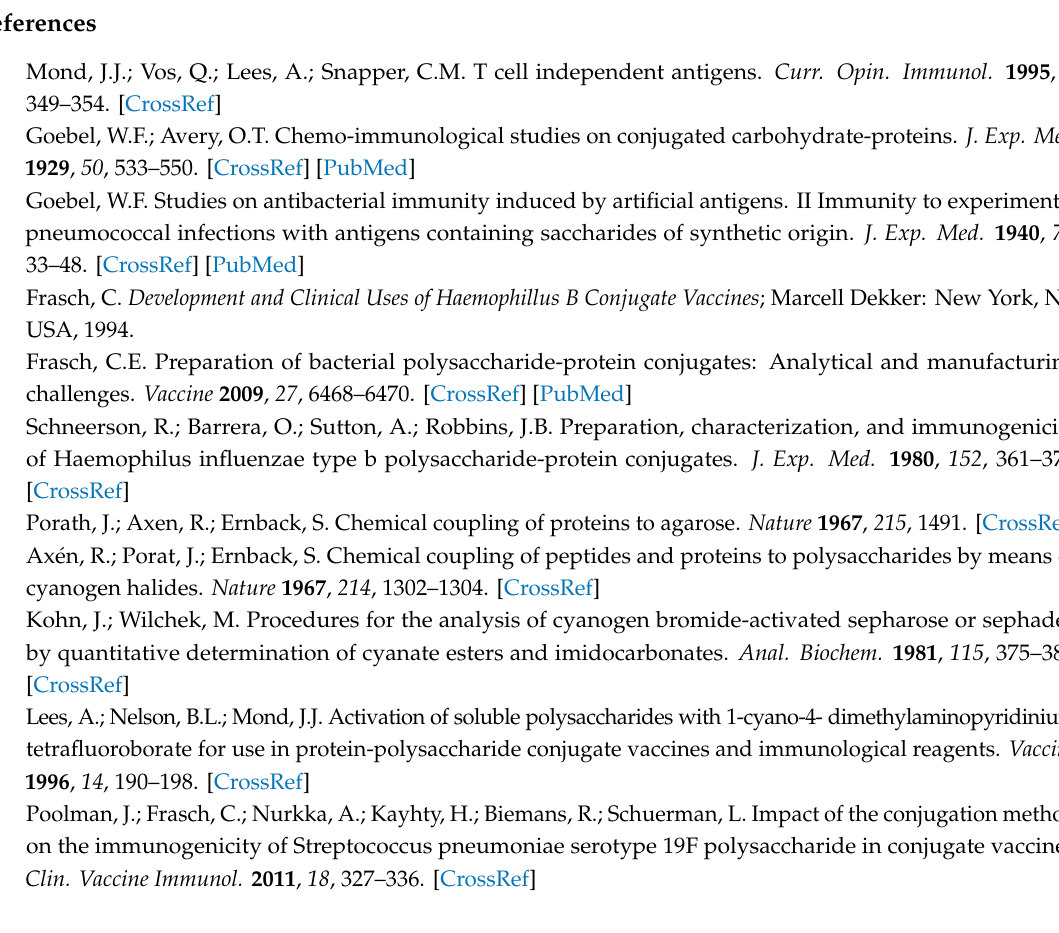
Figure S1: pH change of aqueous solution of CDAP, Figure S2: UV spectra of CDAP diluted into combinations of HCl and NaOH, Figure S3: CDAP consumption in the presence and absence of 10 mg / mL dextran, pH 9 at 0 ◦ C, Figure S4. Stability of CDAP-activated dextran as a function of pH. Table S1: Functionalization of CDAP-activated dextran with